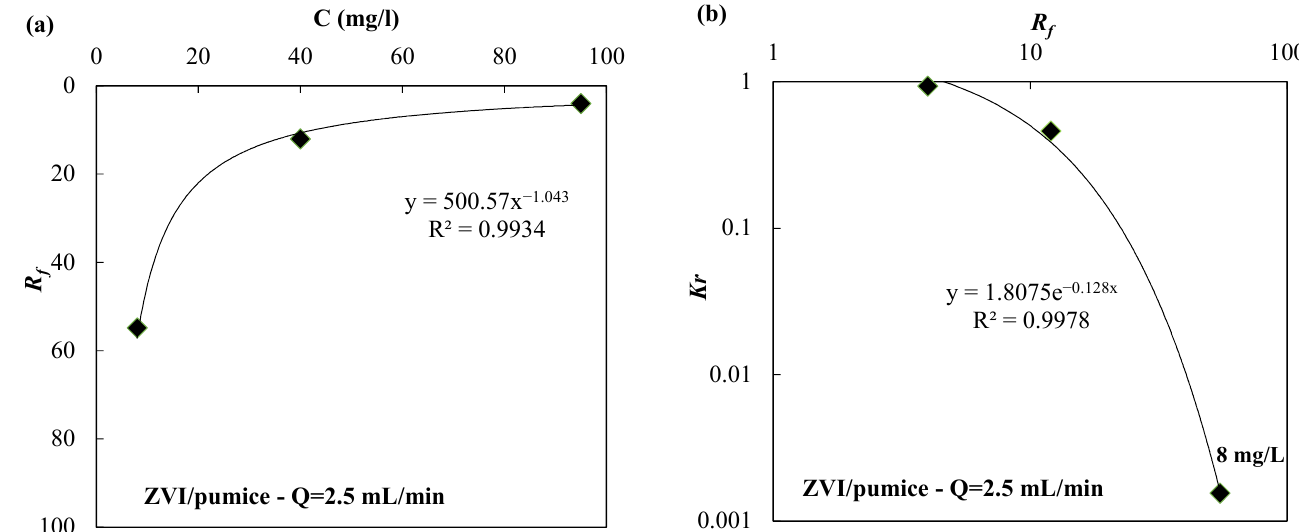
Figure 4. ( a ) R f vs. the initial nickel concentration (C) and ( b ) Kr vs. R f for the ZVI/pumice granular mixture.